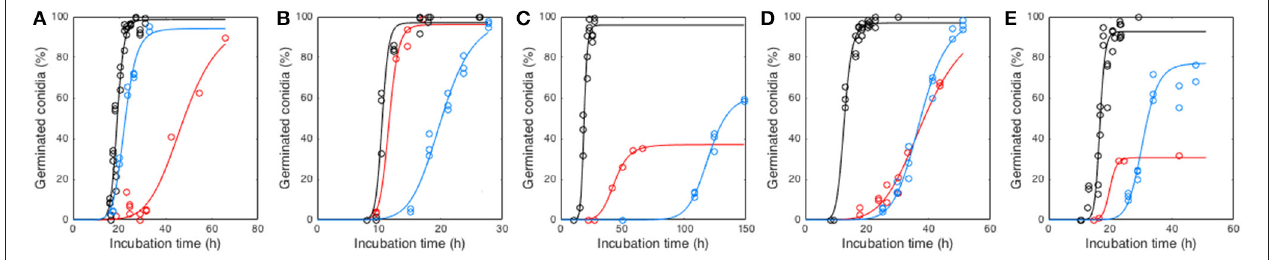
FIGURE 2 | Conidial germination kinetics of Paecilomyces niveus UBOCC-A-11024 (A) , Mucor lanceolatus UBOCC-A-109153 (B) , Penicillium brevicompactum UBOCC-A-110007 (C) , Penicillium expansum UBOCC-A-110032 (D) and Penicillium roqueforti UBOCC-A-113022 (E) on PDA (pH 4.2, 0.980 a w ) at 25 ◦ C under atmospheric air i.e., 21% O 2 and 0.03% CO 2 (black), 0.36% O 2 and 0.03% CO 2 (red) or 69% CO 2 and 5% O 2 (blue). Circles represent observed germination percentages (%) and solid lines are obtained from the Equation (1) model.